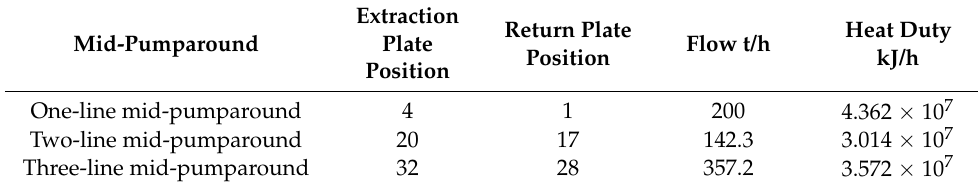
Table 2. Circulating parameters of the atmospheric column in the middle section.